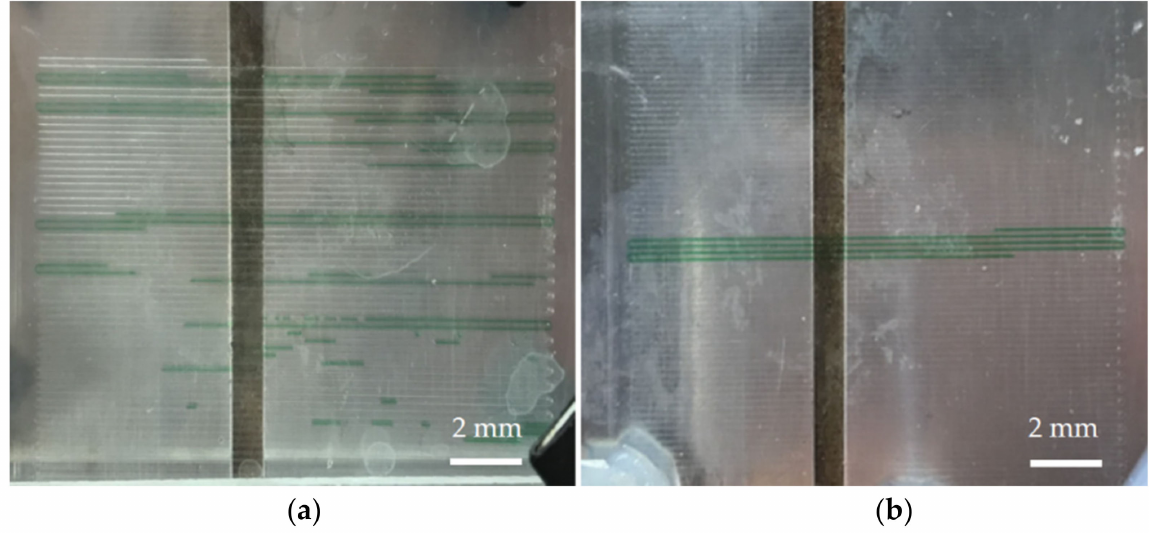
Figure 3. Fill the channel with fluorinated oil and encapsulate the sample in the oil phase; increase the pressure of the fluid in the microchannel to suppress the generation of bubbles. ( a ) When the sample is not encapsulated with oil, the sample passes through the high-temperature zone and generates bubbles, causing in the destabilization of flow. ( b ) When the sample is encapsulated in the oil phase, the bubbles are suppressed, causing the stabilization of